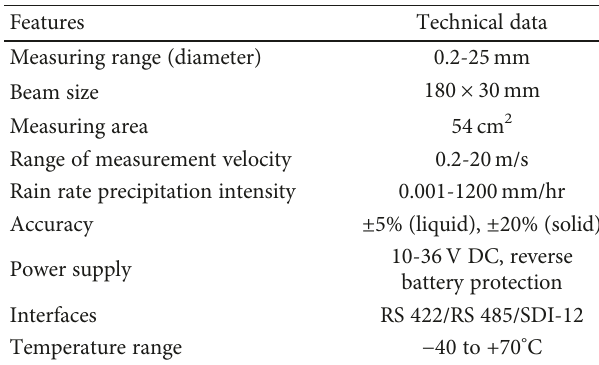
Table 2: Technical speci fi cations of the OTT Parsivel disdrometer (OTT)